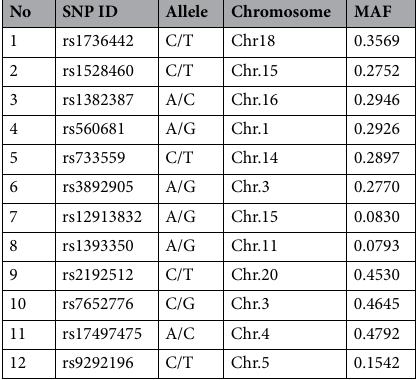
Table 1. SNP loci for analysis of ultraviolet-irradiated dried blood samples. MAF minor allele